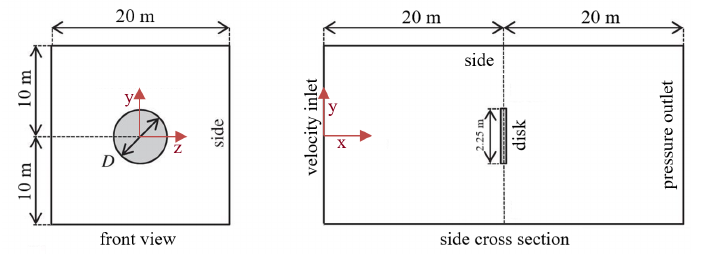
Figure 5. Isolated propeller and computational